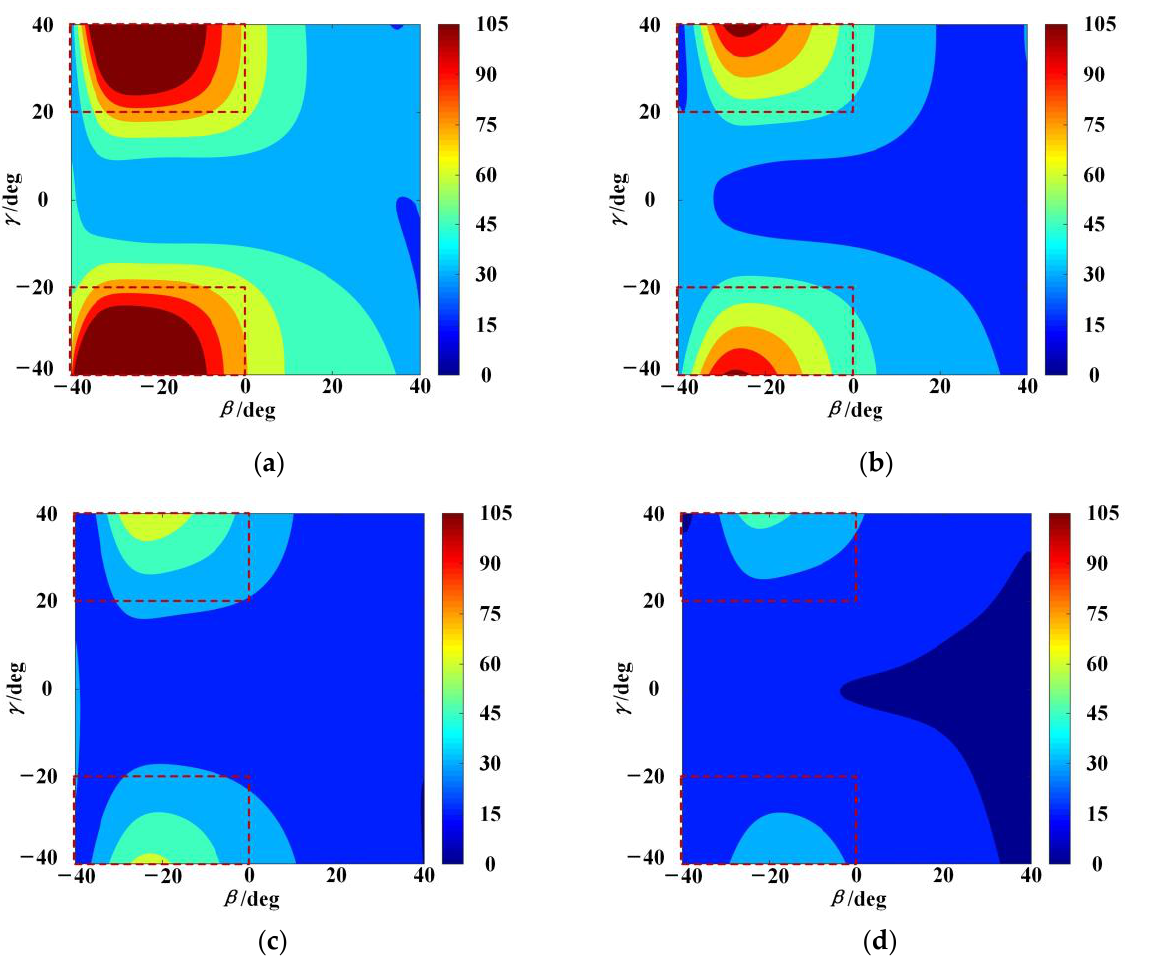
Figure 9. Influence of operational height on the distributions of κ in the orientation workspace when